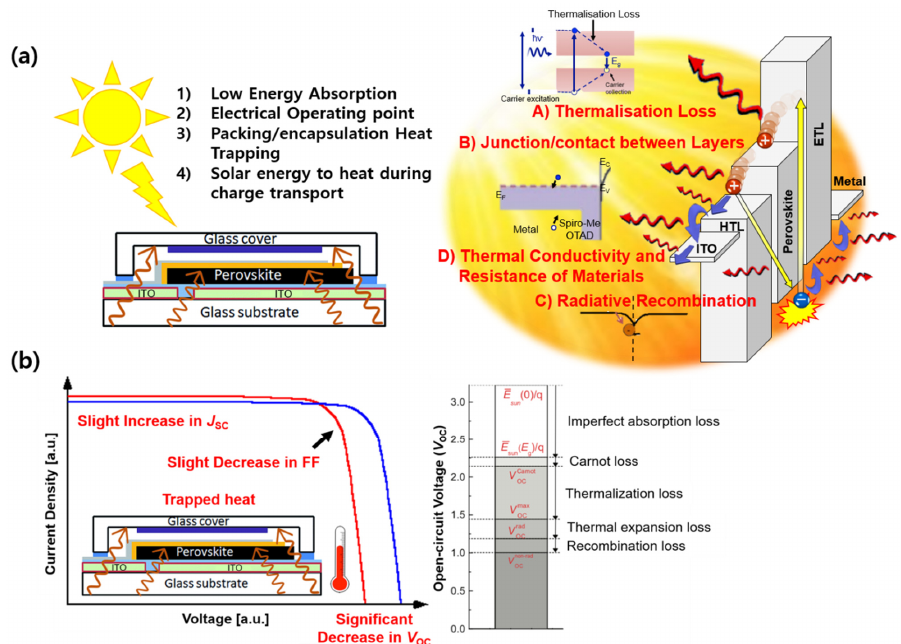
Figure 3. ( a ) Origin of the heat trap categorised by possible sources ( left ) and the detailed illustration of heat generation during the operation of PSC ( right ) ( b ) Mechanism of PSC degradation due to heat trapping during the PSC operation and the breakdown on the origin of the V OC loss related to the change in photovoltaic performance of the PSC. The MWNT-added UV epoxy resin was used in the packaging process to enhance the moisture barrier property, with the encapsulating pressure of 14.71 N cm − 2 (Figure S8). Before fabricating PSCs, we wanted to consolidate the effect of the MWNT addition and find the optimal amount of MWNT. Therefore, we conducted water contact angle tests to confirm that the addition of MWNT increased the hydrophobicity of the UV epoxy resin. The water contact angle images of epoxy resin and MWNT-added UV epoxy resin are shown in Figure 4a. The contact angle of the MWNT-added UV epoxy resin (87.9°) was larger than that of the bare epoxy resin (81.1°) [46]. For further investigation, water vapour